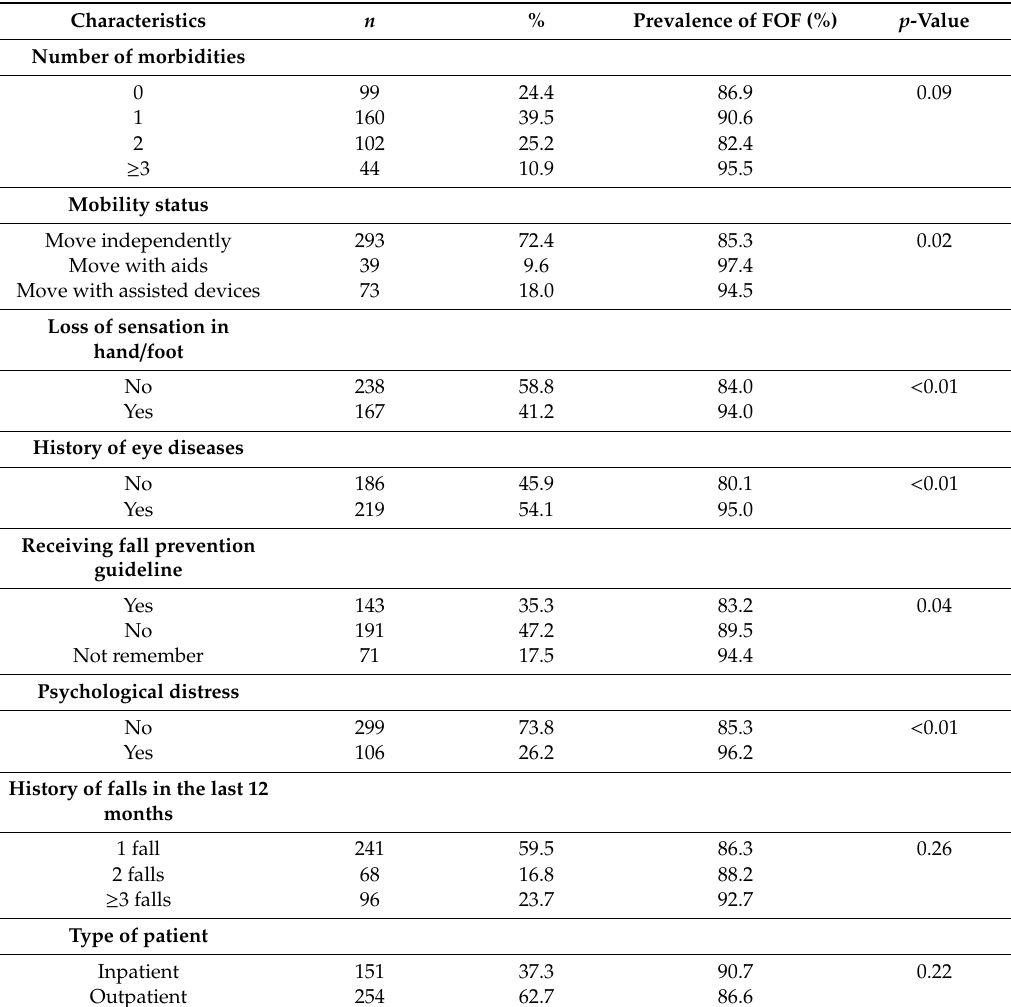
Table 2. Prevalence of FOF according to clinical